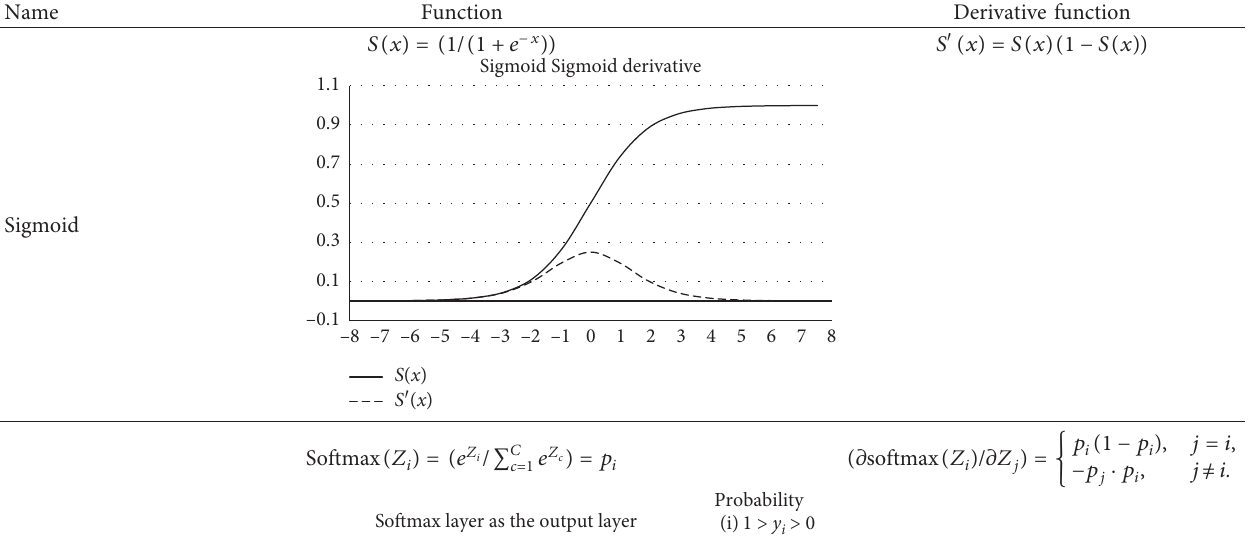
Table 3: Activation functions and